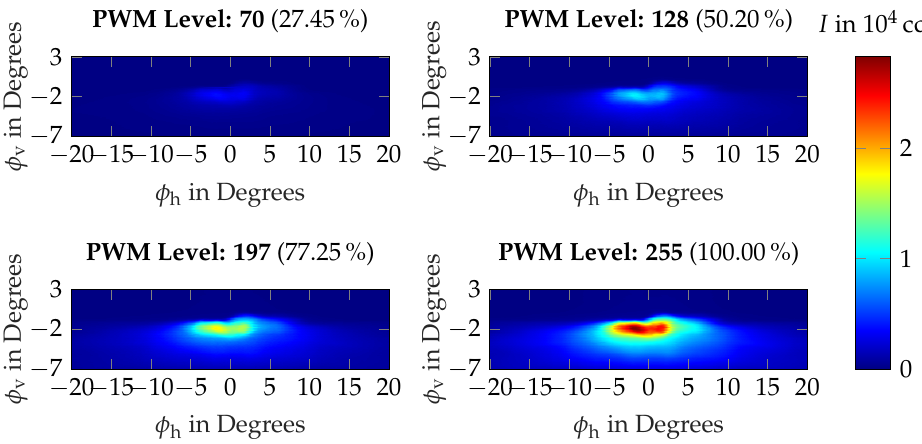
Figure 3. Dimmed low beam distributions of the BMW 3 Series LED headlight used in the tests; PWM dimming changes the absolute intensity of the low beam distribution, while the light distribution itself remains unaffected by the